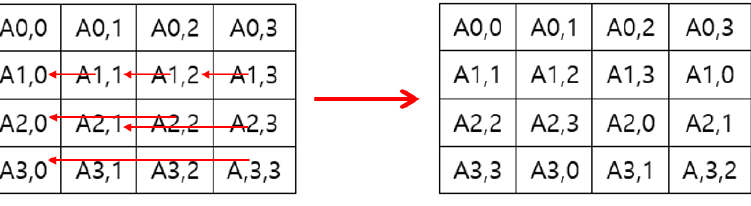
Figure 5. Shift Figure 5. Shift Row.